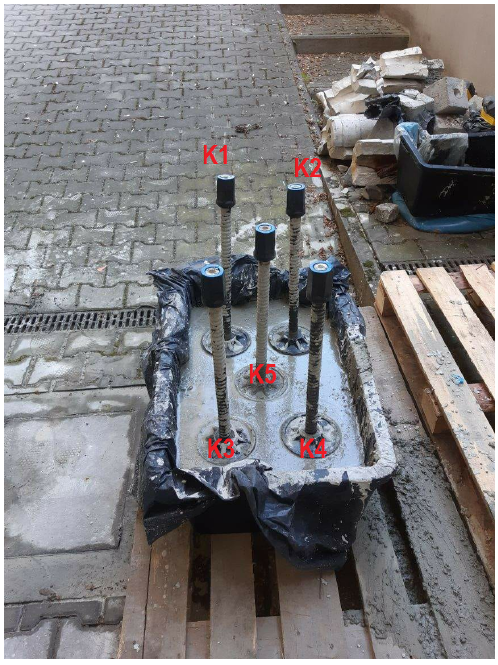
Figure 14. Laboratory model of bolted